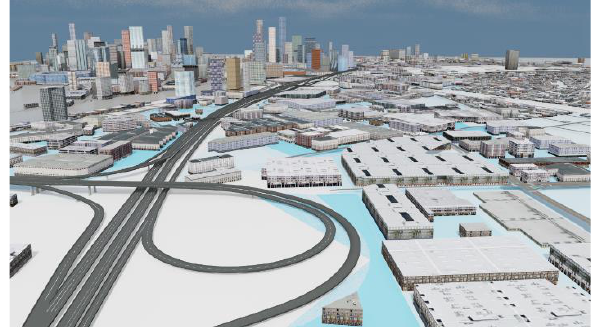
Figure 7: Showing the freeway and textured buildings adjacent